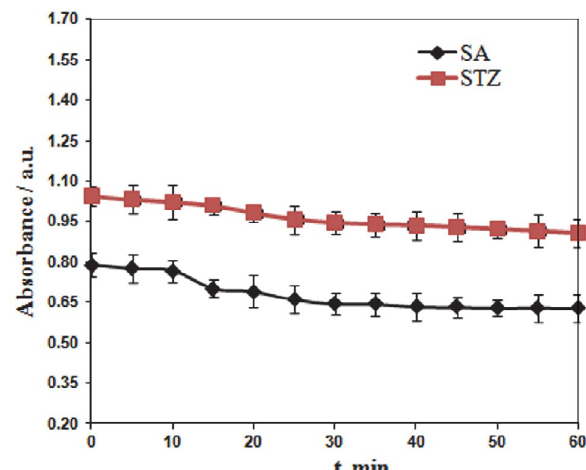
Fig. 9. Effect of the keeping time on the absorbance of azocoupling product of diazotized SA and STZ with AM. 1. C SA = 2.0 . 10 –4 M, C HCl = 0.6 M; 2. C STZ = 1.9 . 10 –4 M, C HCl = 0.7 M; C NaNO = 3.0 . 10 –3 2 M, C AM = 3.75 . 10 –5 M, C Na = 0.1 M, pH = 10.5, n = 2 B 4 O 7